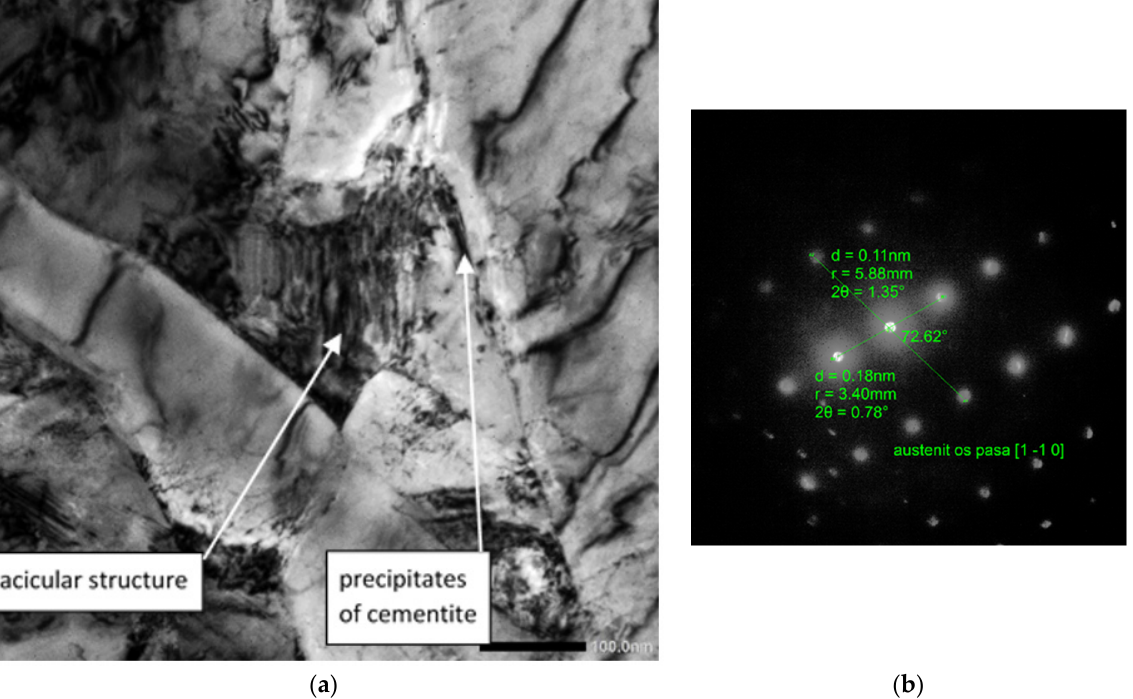
Figure 3. An image of the microstructure for variant 1; ( a ). Microstructure with visible bainitic and martensitic island (B + M) of very fine coniferous structure, image in bright field magnification 15 kx; ( b ). Electron diffraction from retained austenite in B + M island. The axis of the austenite belt [1 1 0 ] 1 (cid:3364) 0 (cid:4671) .